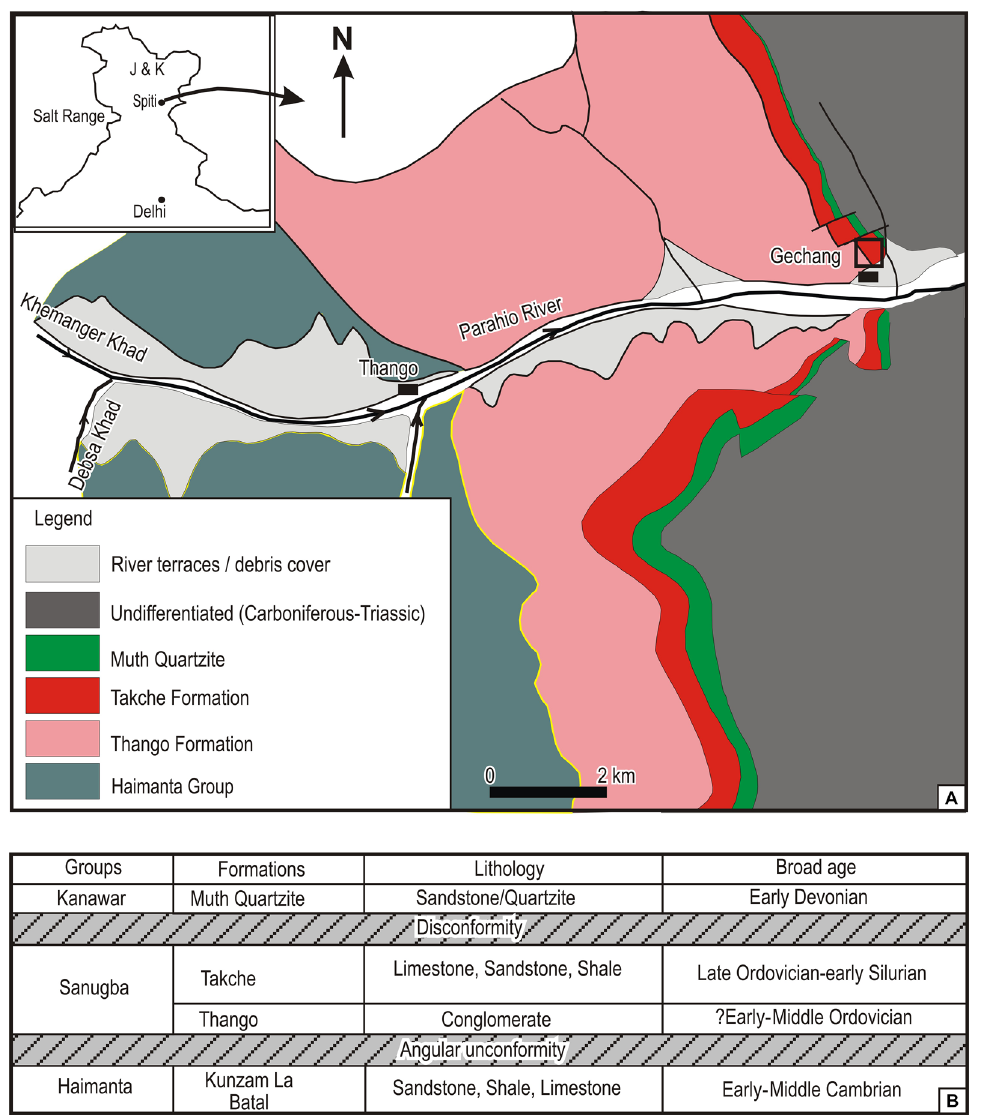
Fig. 1. Location and geological map of the Parahio Valley, Spiti, Himalaya, India. ( A ) detailed geological map of the Parahio Valley, Spiti, the inset showing the studied section near the village Gechang; ( B ) lithostratigraphic classification of the Ordovician– Silurian Sanugba Group in Spiti, Himalaya (after Bhargava & Bassi 1998; Srikantia & Bhargava 2018).